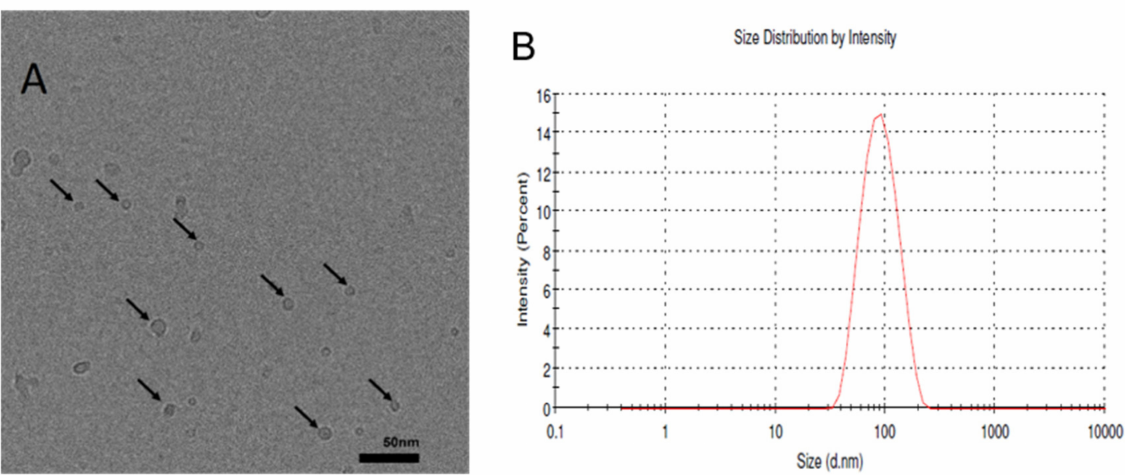
Figure 4. ( A ) The cryogenic electron microscopy (Cryo-EM) image showing the formation of BBR-loaded small liposomes (mixed micelles) (FJ17) with sodium deoxycholate (SDC) in the composition. The liposomes were generated by the ethanol- injection method. Scale bar = 50 nm. ( B ) The size distribution of the corresponding liposomes (FJ17) determined by the Zetasizer Nano ZSP